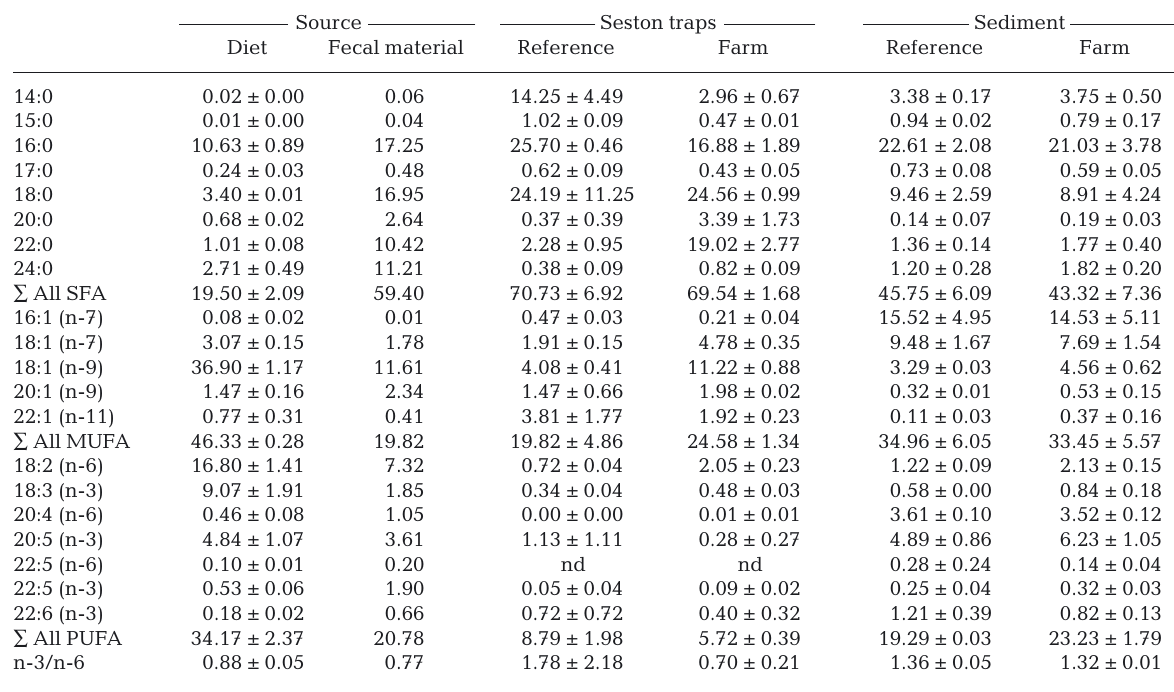
Table A1. Fatty acid profiles of farm effluent source and environmental samples (%, mean ± SE; single values for fecal material). SFA, MUFA, PUFA: saturated, monounsaturated, and polyunsaturated fatty acids, respectively. nd: not detected